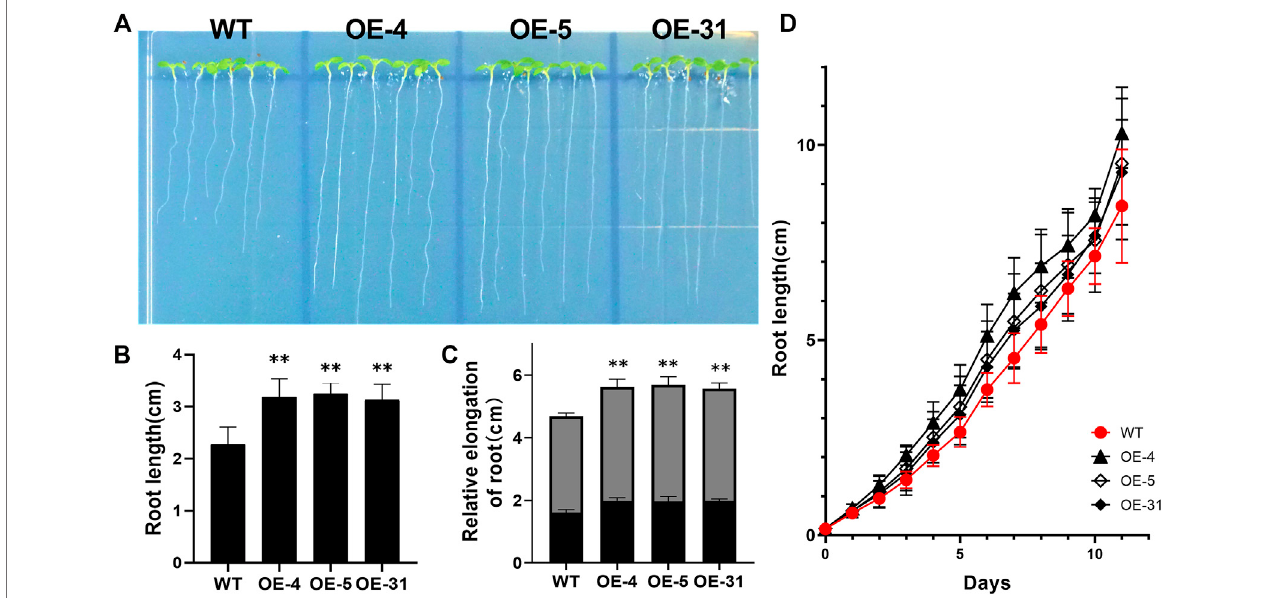
FIGURE6| PhenotypicdifferencesintheprimaryrootlengthbetweenthewildtypeandOElines. (A) RootmorphologyoftheOEseedlingsandwildtype.Five-day- old seedlings culturedin1/2 Murashigeand Skoog(MS) wereobserved. (B) The primary root lengthof5-day-oldwild type andthe transgenic seedlings. (C) Therelative elongation ofroots after thethird(black) and fi fth(gray)days. N =36±SD fromthree independent biological replicates. (D) Theprimary root lengthcomparison between the OE lines and wild type during 11 days of growth. The error bars represent the means of three technical replicates ±SD. Statistically signi fi cant differences from the control group are indicated as ** p < 0.01.